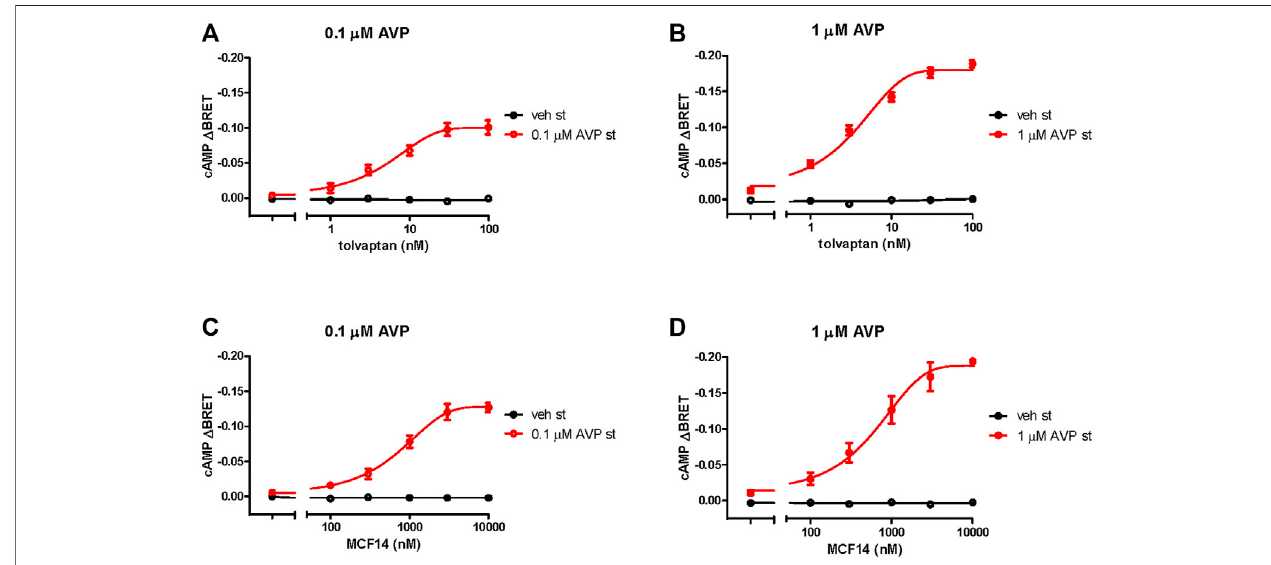
FIGURE5| EffectsofdifferentconcentrationsofpharmacochaperonetreatmentsonthecAMPgenerationofS127F-V2R.Effectofvarious (A,B) tolvaptanand (C, D) MCF14 pretreatment concentrations on the cAMP generation in response to 0.1 µM ( (A, C) , red traces) or 1 µM AVP ( (B, D) , red traces) stimulation. HEK293 cells were transiently transfected with the plasmids of the Epac-BRET sensor and S127F-V2R. 24 hours after the transfection the cells were incubated with different concentrations of tolvaptan or MCF14 for eighteen hours. The effect of stimulation was calculated as the BRET ratio difference ( Δ BRET) between the BRET ratio values taken before and 5 min after the stimulation. The concentration-response sigmoidal curve was generated using non-linear regression with the GraphPad Prism software. Mean values ± S.E. are shown ( n = 3). Since increasing cAMP decreases the BRET ratio, the y axis was inverted to visually represent cAMP level changes.